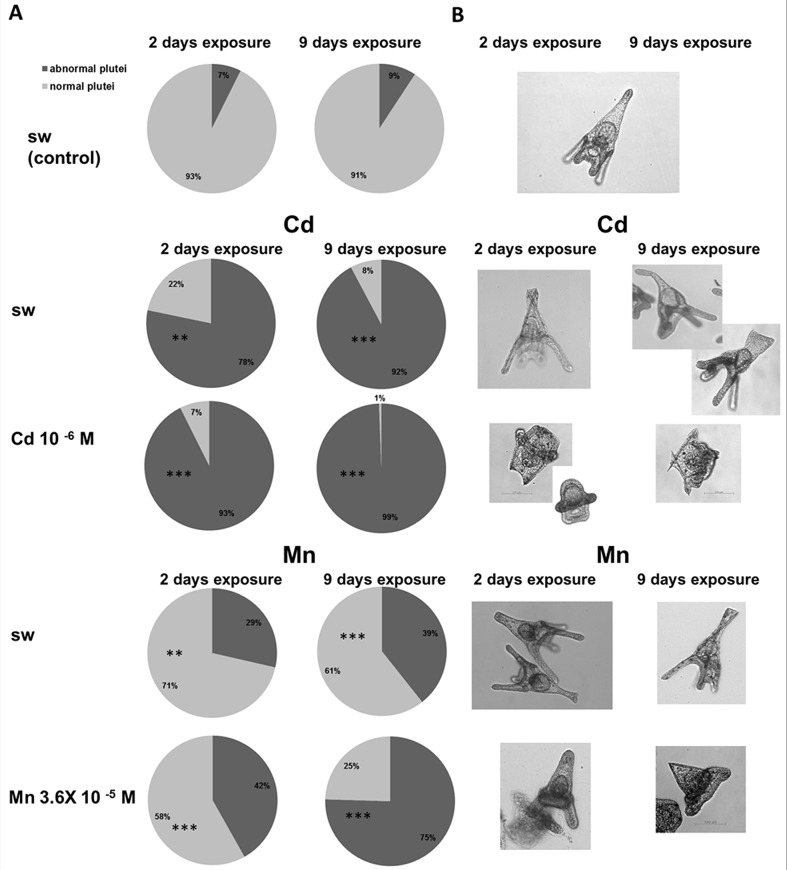
Morphological analysis of the progeny of P. lividus females exposed to cadmium and manganese.Females were treated for 2 and 9 days with cadmium (Cd) 10−6 M and manganese (Mn) 3.6 x 10−5 M, as described in Materials and Methods. Offspring was reared in sea water (sw) or in the presence of the metal. The development was monitored after 48 hpf. A. Percentage of normal and abnormal plutei; B. Representative pictures of the main abnormalities (bar = 100 μm). Significant differences compared to the control **P<0.01, ***P<0.001; Two-way ANOVA (P<0.05), with Bonferroni’s Post Test. Light grey: normal plutei; dark grey: abnormal plutei. N = 8.